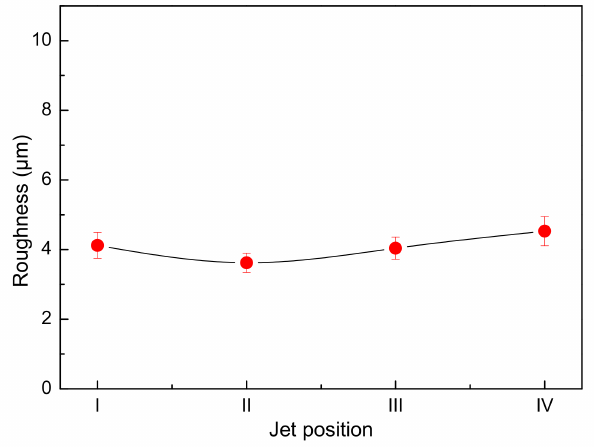
Figure 9. Effect of jet position on the surface roughness of cathode copper in the single-side jet inlet mode. Bars represent standard deviation. The electrolyte circulation rate was 3.0 L · min − 1